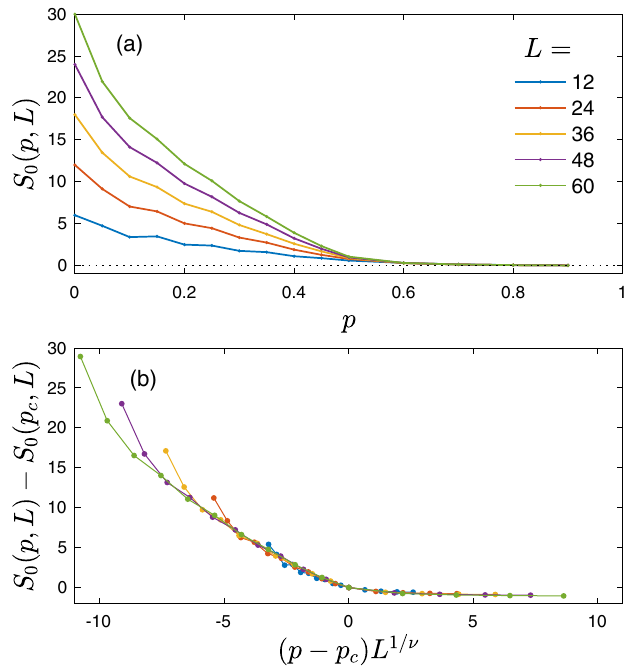
FIG. 10. Demonstration of critical behavior in the zeroth R´enyi 1 = 2 . (a) S entropy near the percolation threshold p 0 as a c ¼ function of p for different values of the system size L , with t ¼ 4 L . (b) Critical scaling of this same data, with ν ¼ 4 = 3 and 1 = 2 taken from the known values for two-dimensional p c ¼ percolation on the square lattice. The vertical axis is S 0 ð p; L Þ − S 0 ð p ; L Þ , where S 0 ð p ; L Þ is the measured value c c of S 0 at p ¼ 1 = 2 for a given value of L